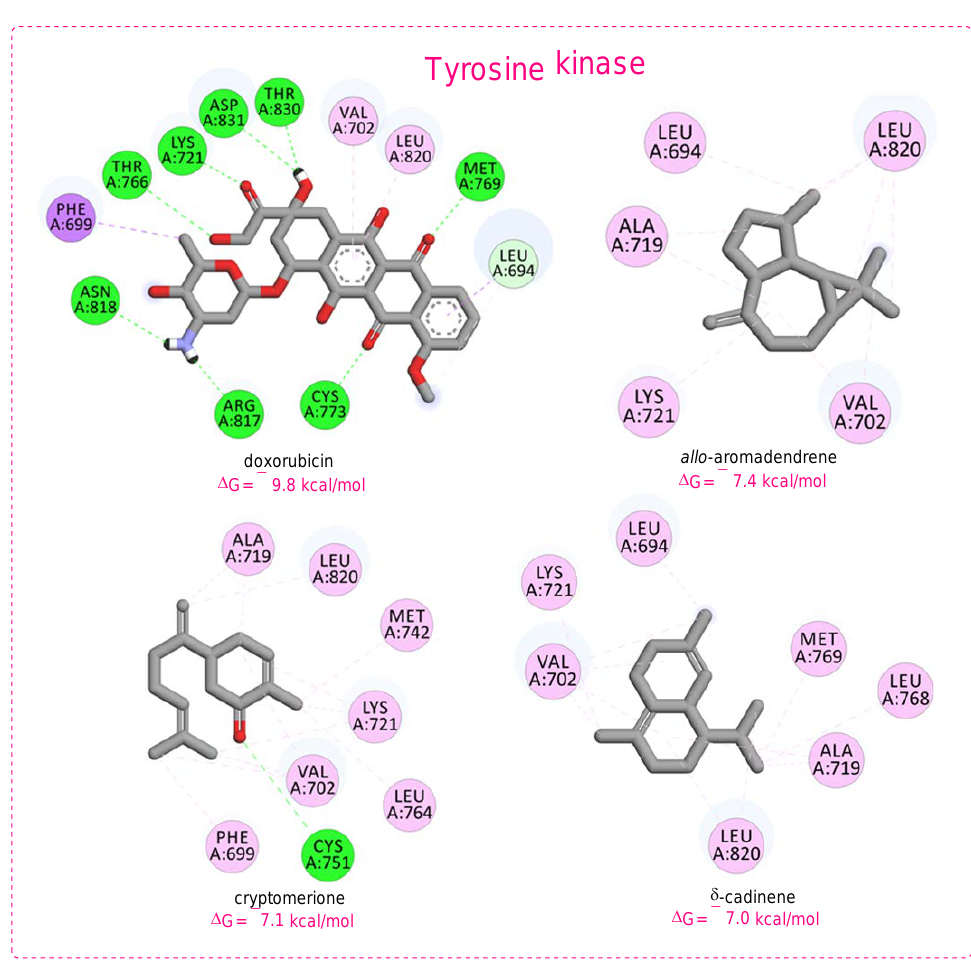
Figure 2. Main interactions observed for doxorubicin (positive control) and the top-scored inhibitors of tyrosine kinase (1M17) by docking analysis.